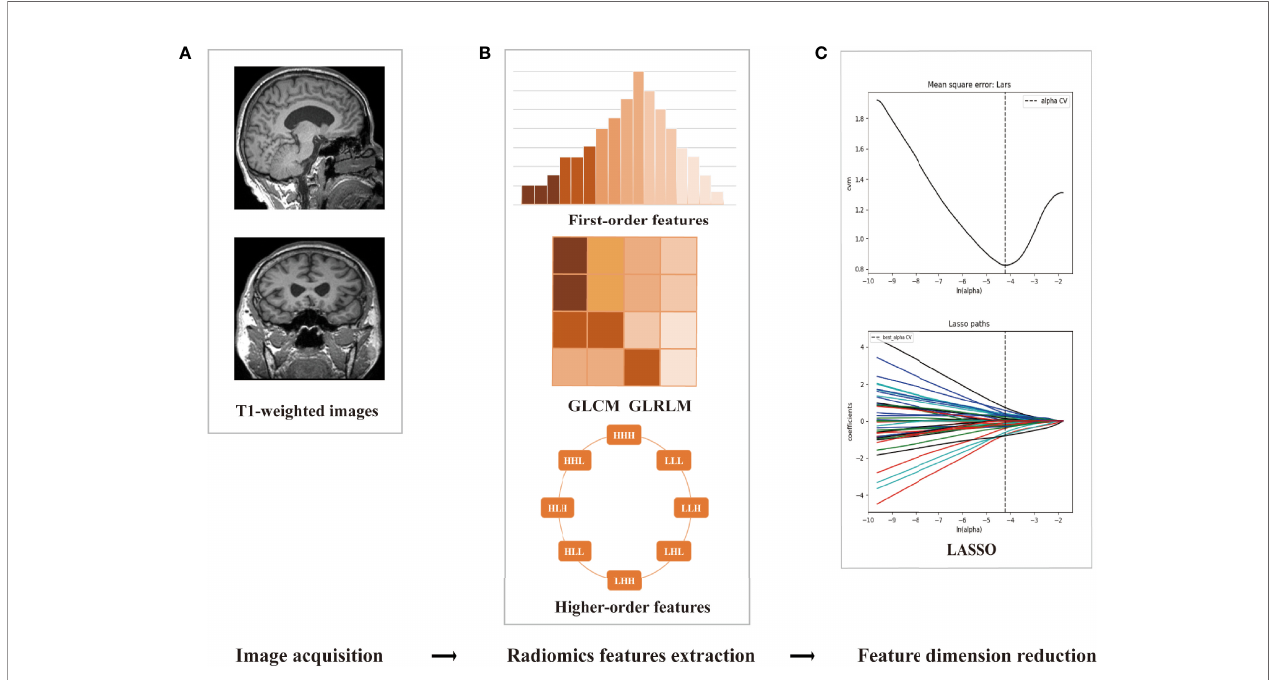
FIGURE 1 | The framework of the radiomics work fl ow. (A) Data preprocessing and cortex/subcortical brain region segmentation. (B) Three categories of radiomics feature extraction. (C) Employing the least absolute shrinkage and selection operator (LASSO) algorithm to reduce the redundancy feature.